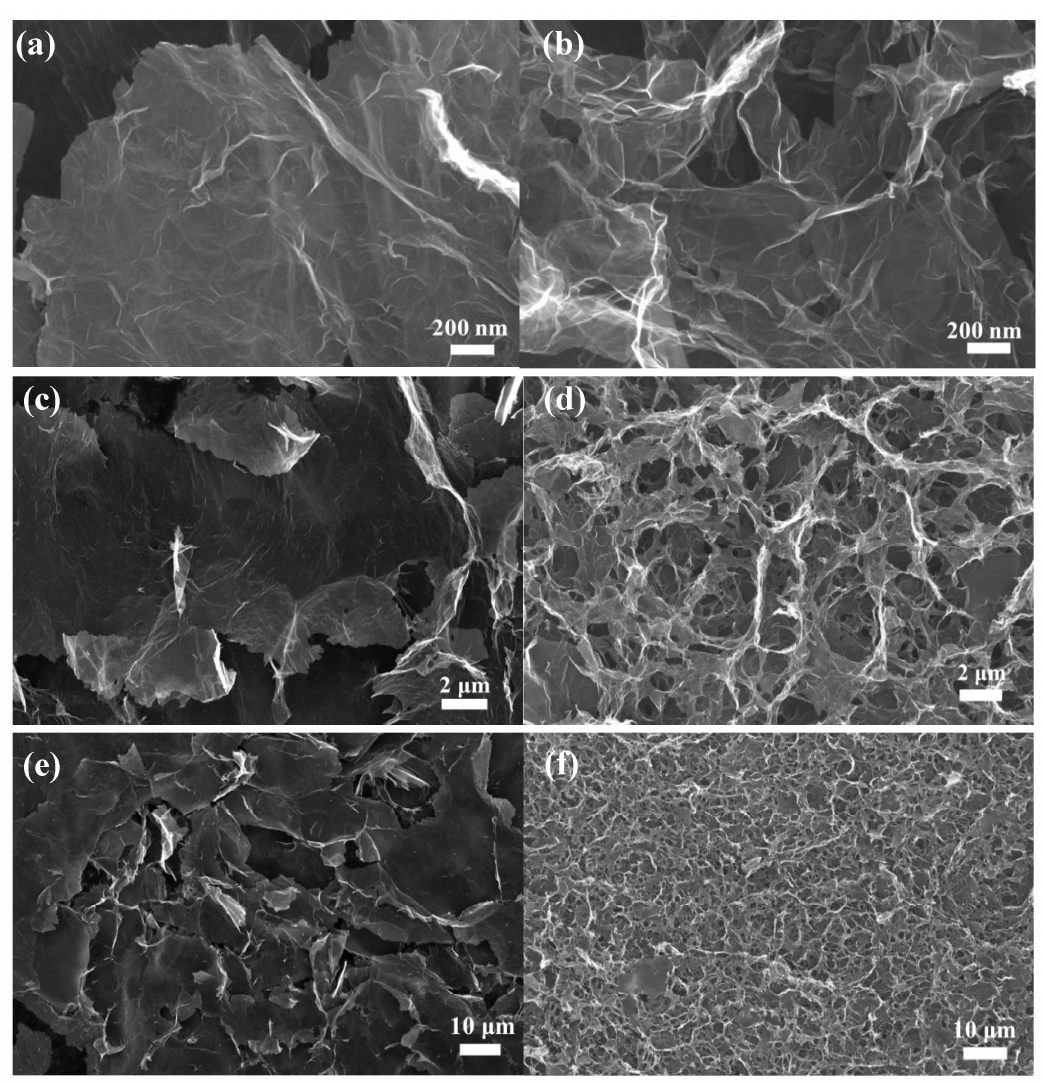
Figure 2. Scanning electron microscope (SEM) images of pure GA ( a , c , e ) and composite GA with MoS 2 ( b , d , f ). The GO concentration for both GAs was 4 mg/mL, and the concentration of MoS 2 was 5 wt %. The BET (Brunauer–Emmett–Teller) surface area test showed that the specific surface areas for the above pure and composite GAs were 182.8 and 91.8 m 2 /g, respectively.